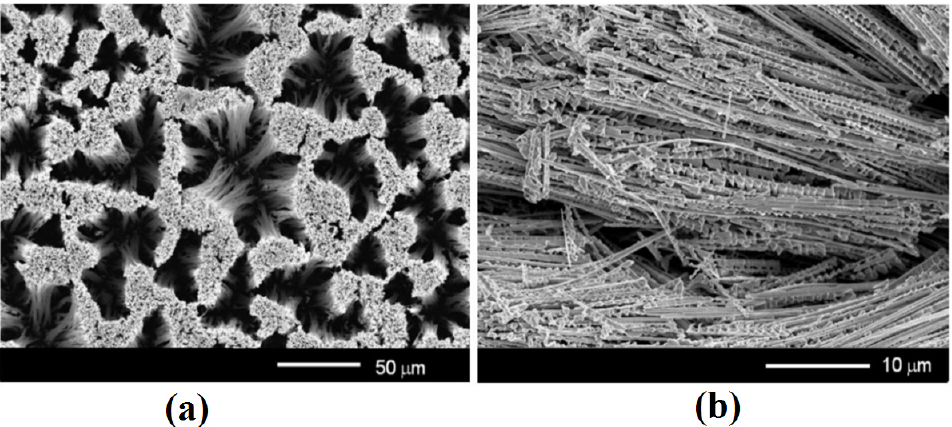
Figure 1. Top view SEM images of anodized GaAs crystals with crystallographic orientations (111)B ( a ) and (001) ( b ) at applied anodization potential of 4 V in 1M HNO 3 for 15 min. ( a ) and (001) ( b ) at applied anodization potential of 4 V in 1 M HNO